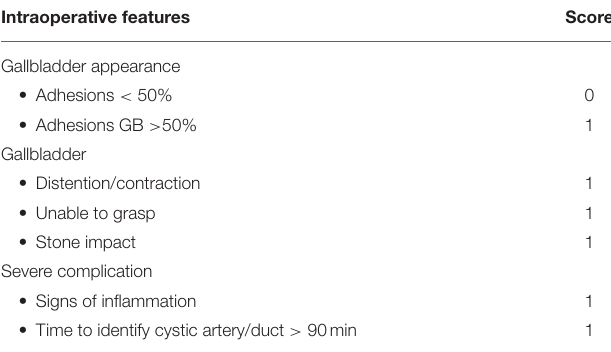
TABLE 2 | Intraoperative macroscopic features.